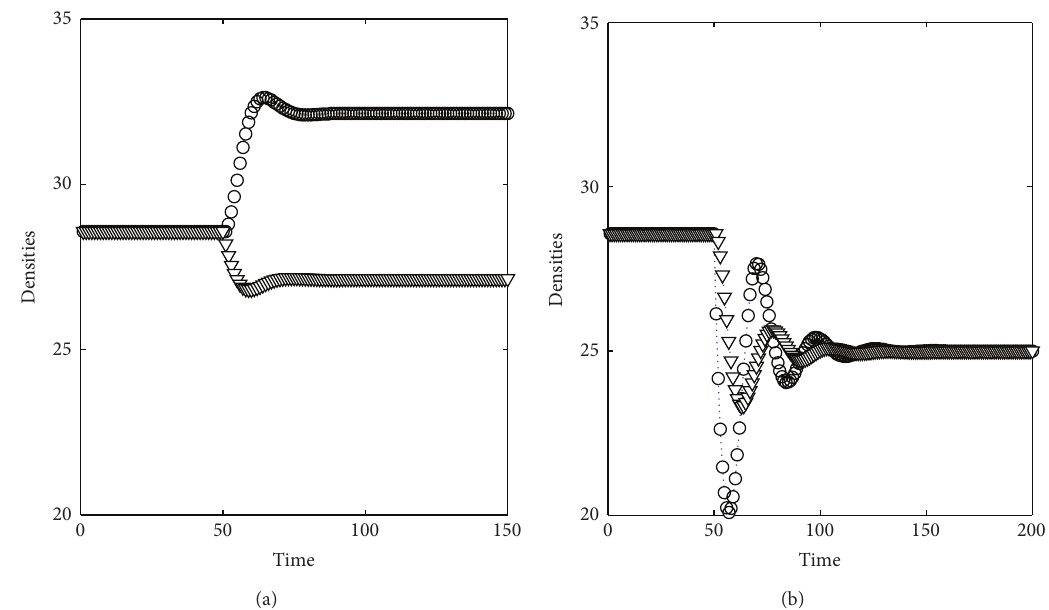
Figure 2: Typical examples of predator ( ∇ ) and prey ( ∘ ) population dynamics. Allee effect of predator (or prey) starts to occur at 𝑡 = 50 . (a) Predator with Allee effect, and (b) prey with Allee effect. Before the Allee effect ( 𝑡 < 50 ), the system stays in steady state. Parameter values: = 𝑢 = 5 𝑟 = 0.8 , 𝛼 = 0.02 , 𝛽 = 0.09 , 𝐾 = 100 , and 𝑢 1 2